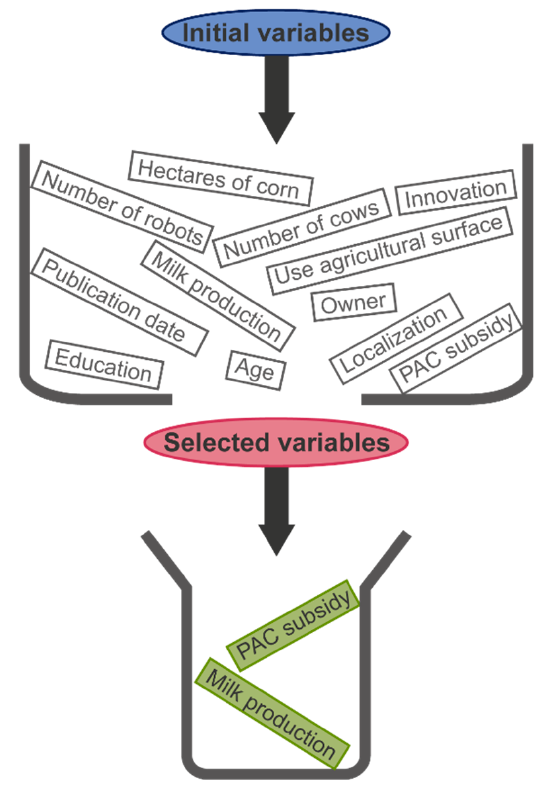
Figure 3. Process of Variables Selection.